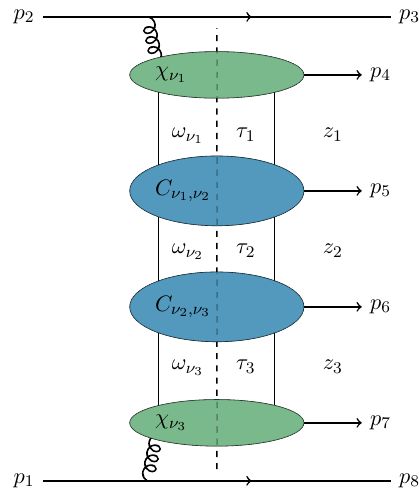
Figure 1 . The structure of the 8 point amplitude in